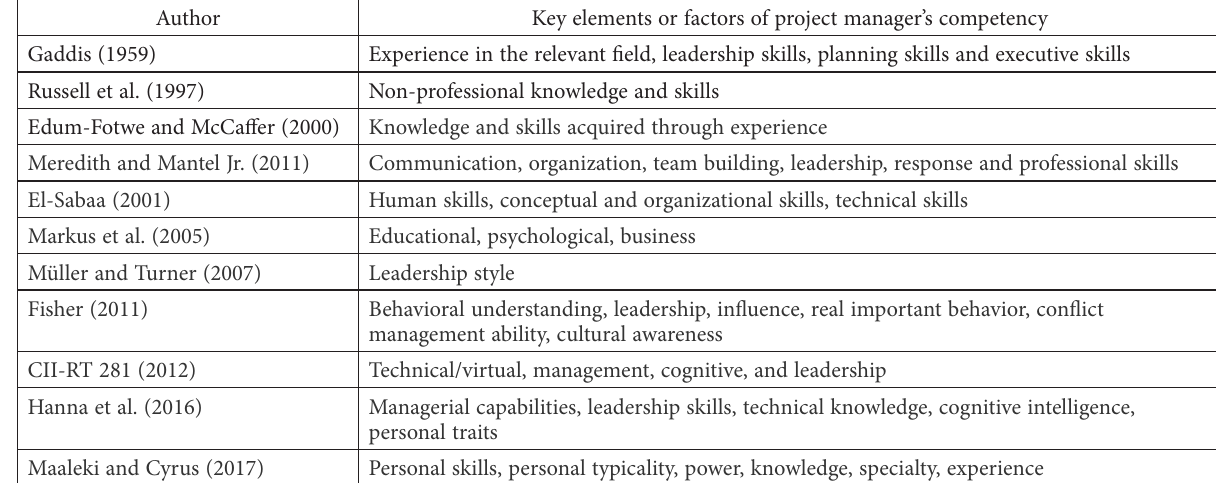
Table 1. Existing studies focusing on key elements or factors of project manager’s